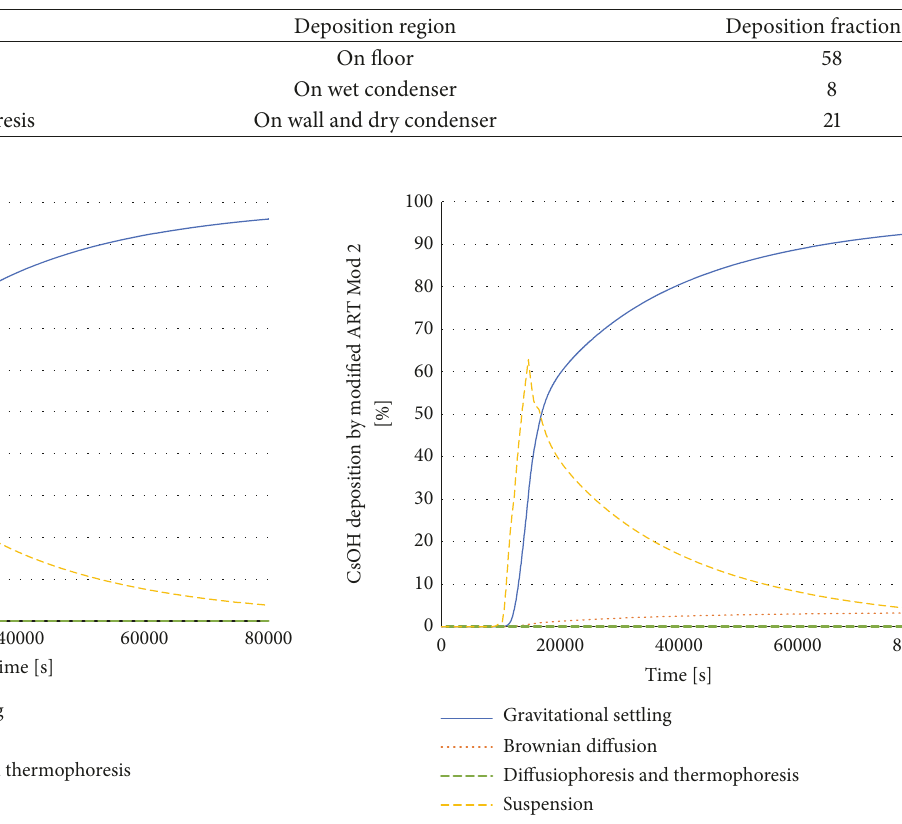
Table 11: Ph´ebus FPT3 experimental results measured with online gamma spectrometry [6, 23].